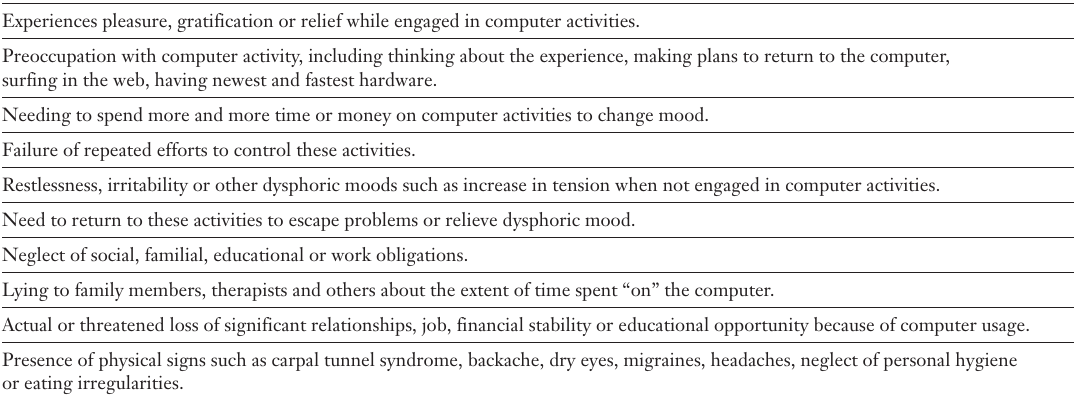
Computer/Internet- Addiction Disorder according to Orzack